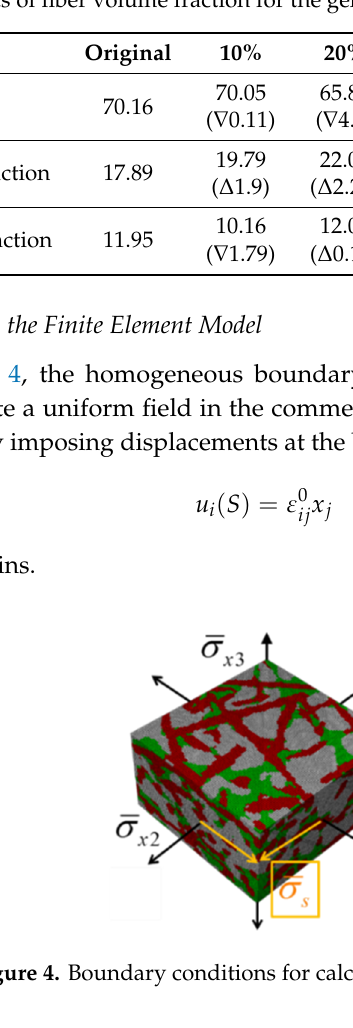
Table 3. Components of fiber volume fraction for the generation of the model microstructures.